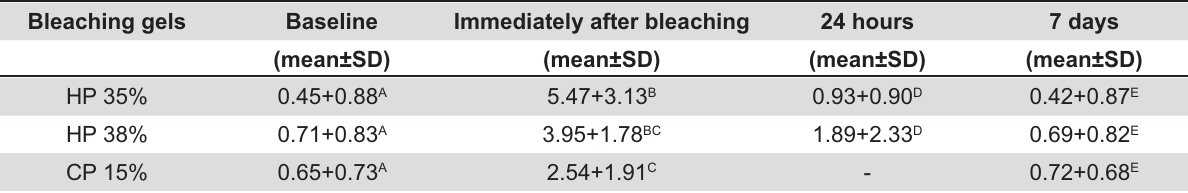
*Capital letters: analysis between lines in the same